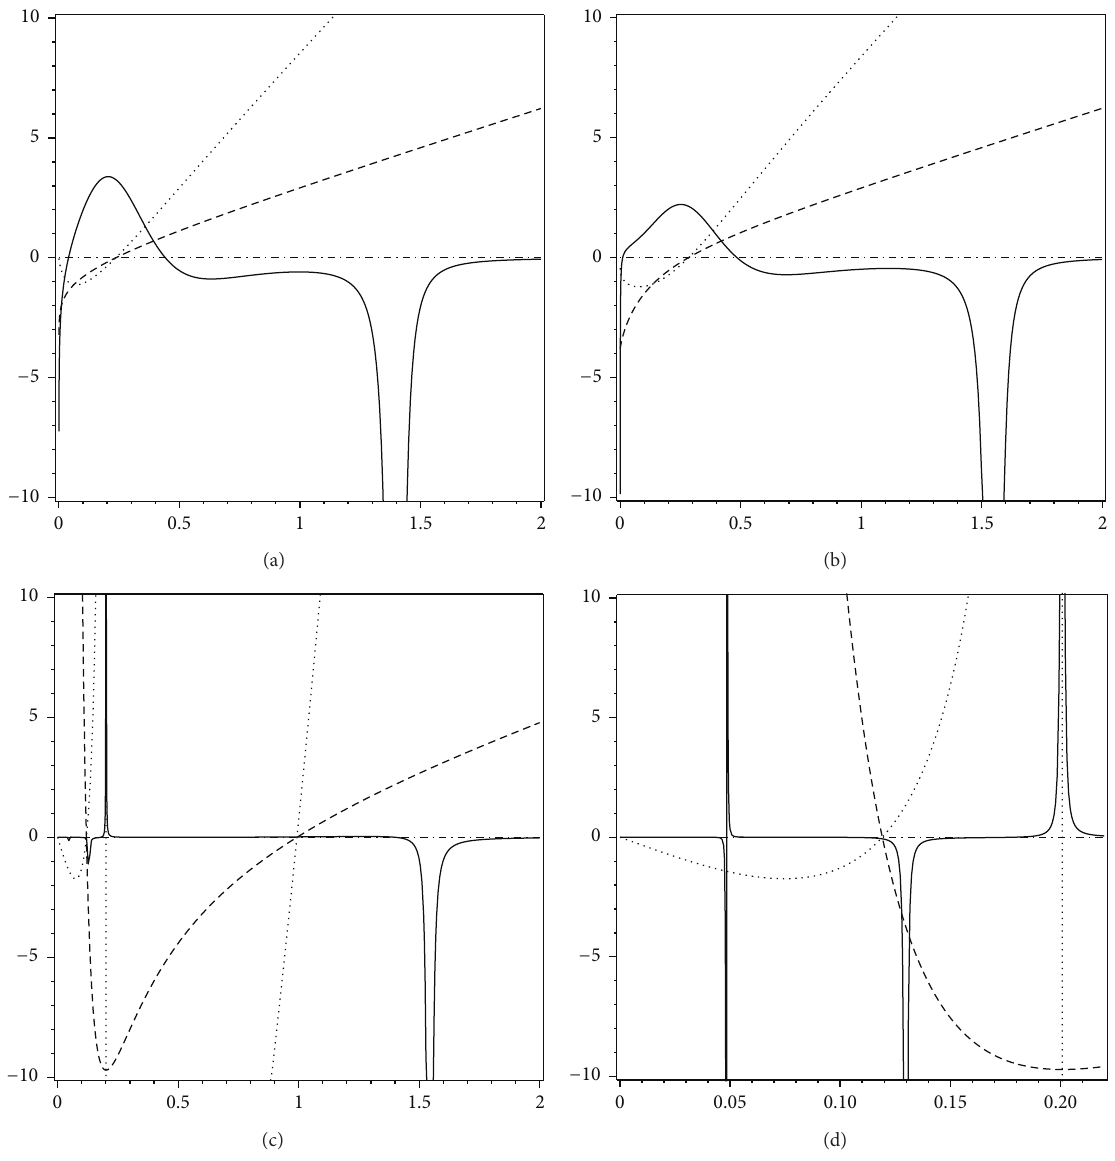
Figure 3: Quevedo Ricci scalar case I (solid line), heat capacity (dotted line), and temperature (dashed line) versus 𝑆 for 𝑙 = 1. HNED model (up-left panel) and SNED model (up-right panel): 𝑞 = 0 . 3, 𝛽 = 1. CNED model (down-left panel) and CNED model (down-right panel): 𝑞 = 1, 𝛼 = 0 . 007 (different